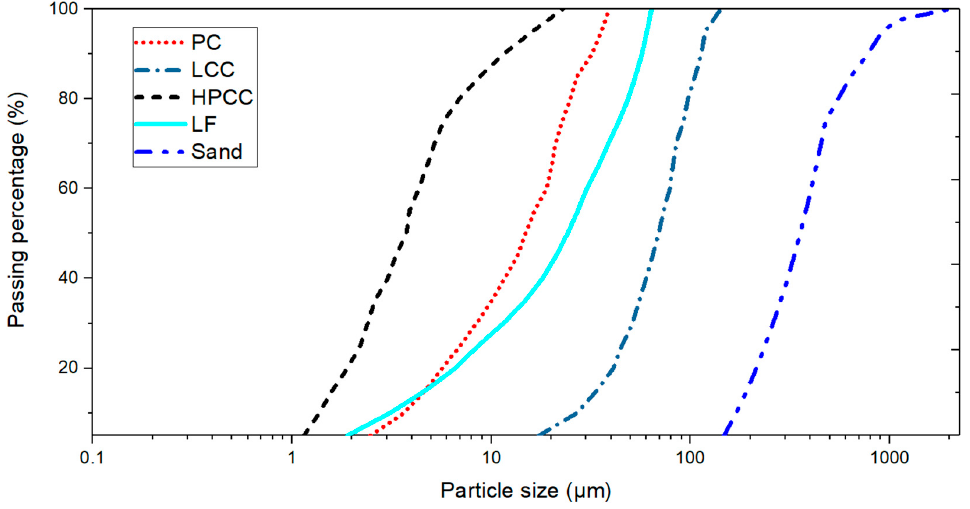
Figure 1. Particle size distribution of dry components. Table 1. The chemical composition of the main components in the binder (wt. %).